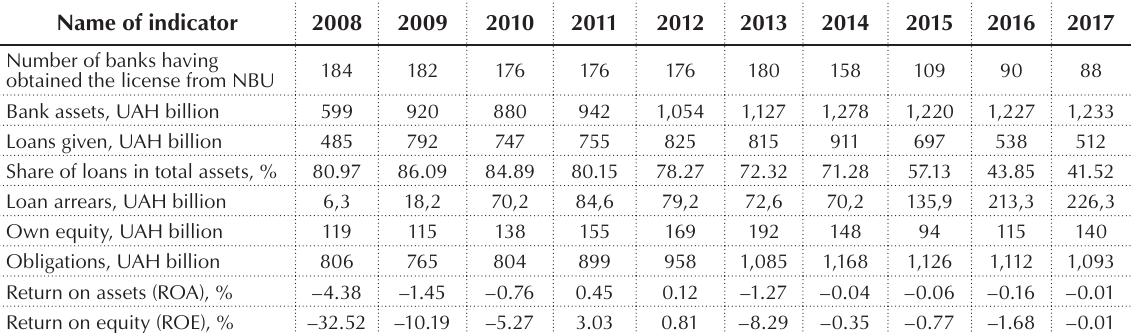
Table 1. (cid:38)(cid:349)(cid:374)(cid:258)(cid:374)(cid:272)(cid:349)(cid:258)(cid:367)(cid:3)(cid:349)(cid:374)(cid:282)(cid:349)(cid:272)(cid:258)(cid:410)(cid:381)(cid:396)(cid:400)(cid:3)(cid:381)(cid:296)(cid:3)(cid:104)(cid:364)(cid:396)(cid:258)(cid:349)(cid:374)(cid:349)(cid:258)(cid:374)(cid:3)(cid:271)(cid:258)(cid:374)(cid:364)(cid:400)(cid:859)(cid:3)(cid:258)(cid:272)(cid:415)(cid:448)(cid:349)(cid:410)(cid:455)(cid:3)(cid:296)(cid:381)(cid:396)(cid:3)(cid:410)(cid:346)(cid:286)(cid:3)(cid:393)(cid:286)(cid:396)(cid:349)(cid:381)(cid:282)(cid:3)(cid:1006)(cid:1004)(cid:1004)(cid:1012)(cid:884)(cid:1006)(cid:1004)(cid:1005)(cid:1011)